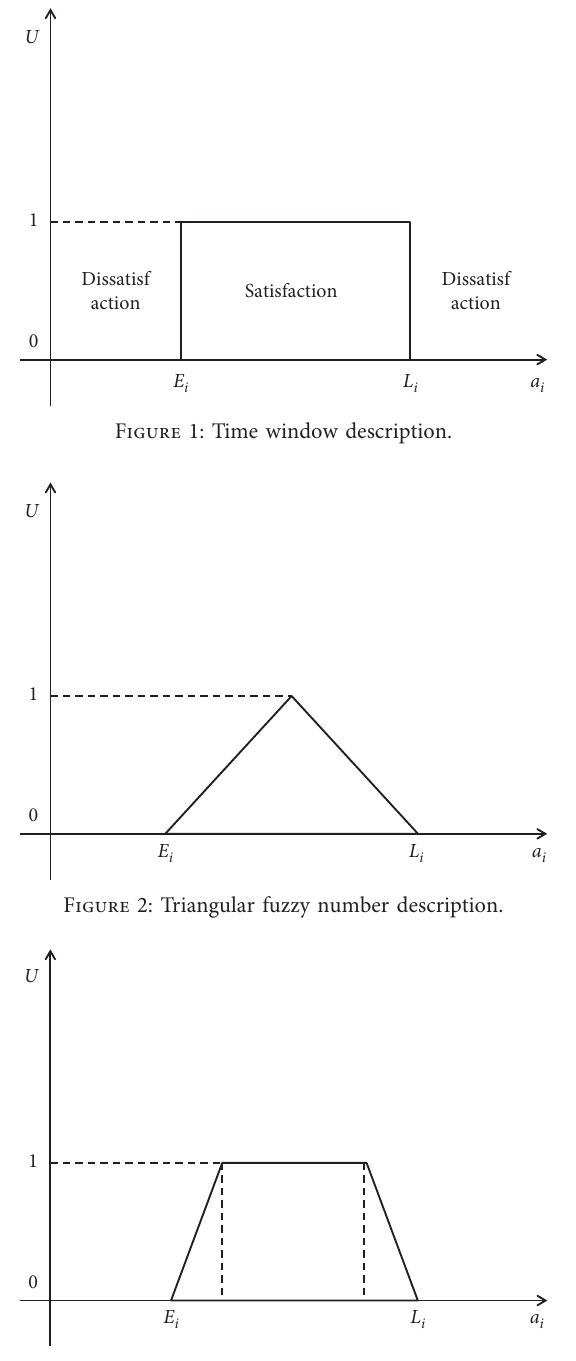
Figure 3: Trapezoidal fuzzy number.